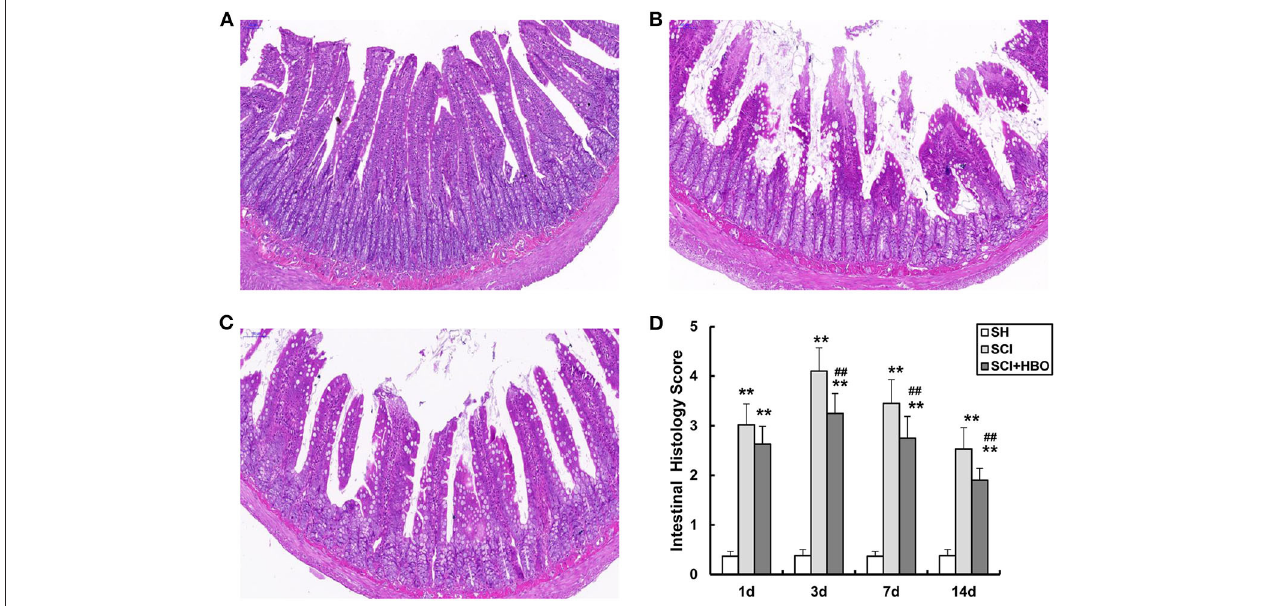
FIGURE 1 | Representative photomicrographs of the jejunum stained with H&E on postoperative day 3 (all images are × 200 magnification, bar = 100 µ m) and analysis of the jejunum mucosal tissue injury in experiment groups. (A) SH group jejunum showing normal villi and consistent villous height. (B) SCI group jejunum specimens were notable for marked short and disorganized intestinal villi, villi necrosis, and increased crypt depth. (C) SCI + HBO group animals showed no evidence of intestinal villi necrosis nor architectural deformity. (D) The histology score of jejunum. Data are presented as mean ± SD. Compared with that of the SH group, the histology score of jejunum was significantly higher in the SCI and SCI + HBO groups (** P < 0.01); HBO treatment significantly decreased the histology score compared with the SCI group ( ## P < 0.01). SH, sham operation; SCI, spinal cord injury; HBO, hyperbaric oxygen.